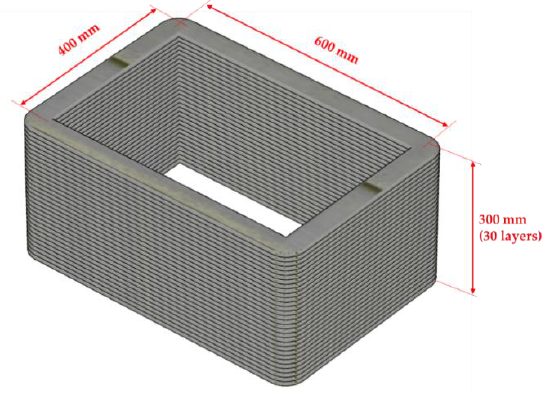
Figure 3. Illustration of a printed column.